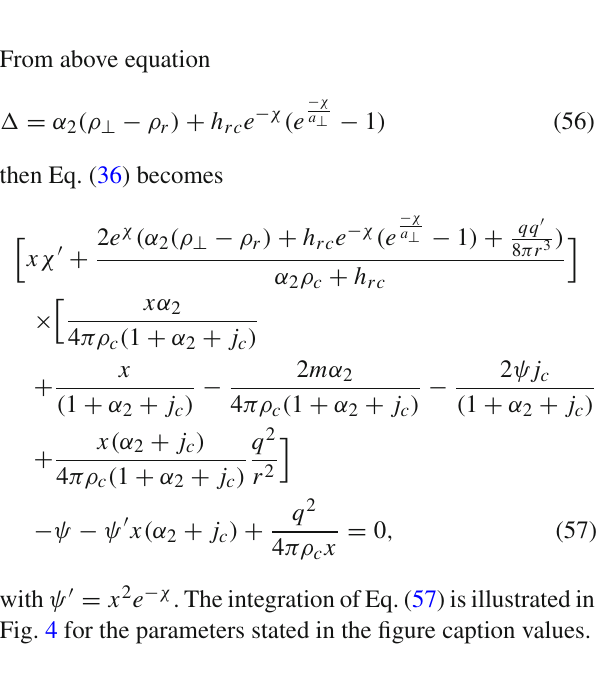
Fig. 3 case 1. Plot ψ T (ψ as a function of q for a r = 2 . 0, j c = 1 . 0, T ) (cid:19) and various p (ϑ) values. 0 . 4790 ( 0 . 1 ) (blue line), 0 . 2350 ( 0 . 5 ) (orange line), 0 . 2249 ( 1 . 0 ) (green line), 0 . 2142 ( 1 . 5 ) (red line). The value of p is taken from the graph in the Fig. 2